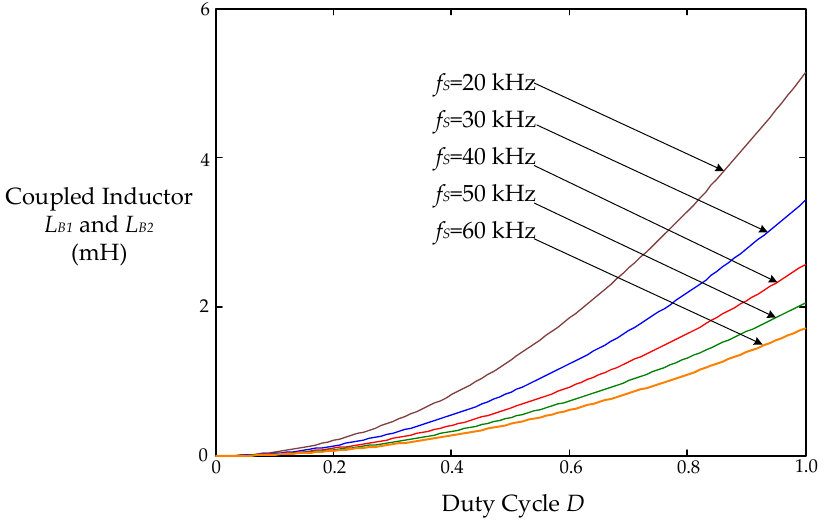
Figure 13. The relationship between the coupled inductors L B1 and L B2 and the duty cycle D at different switching frequencies f S .